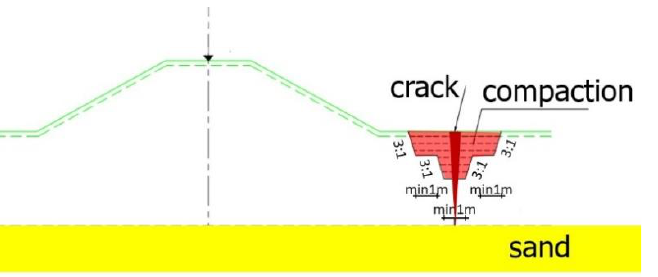
Figure 12. The solution for cracks under the embankment: at the locations of cracks, it is necessary to remove the soil to a depth of at least 1.5 m, and to a width of 1 m, and to compact the clay material in layers.